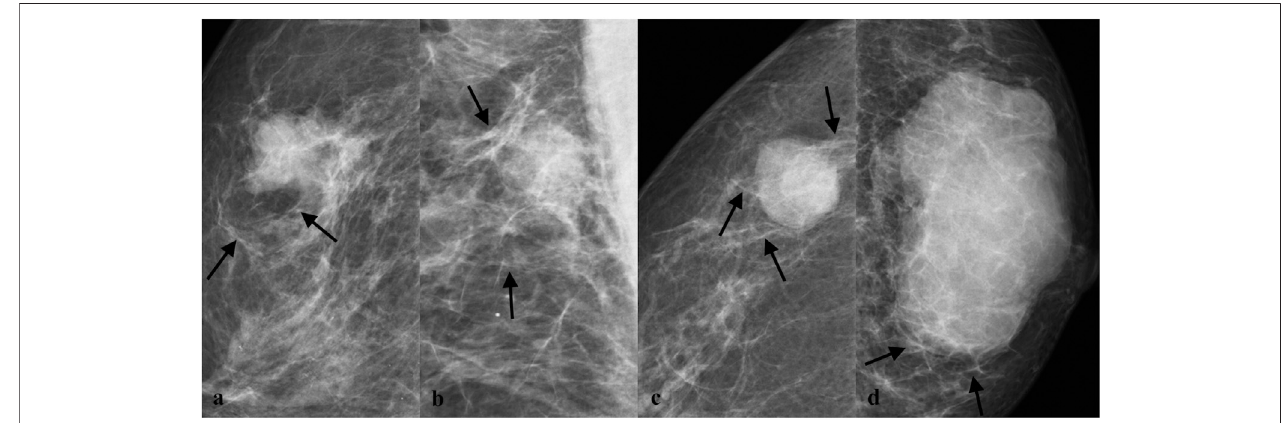
FIGURE 4 | Subclassi fi cation of trabecular abnormalities. (A) A mass with parallel trabecula sign in a 56-year-old woman proved to be invasive ductal carcinoma grade Ⅲ pathologically. (B) A mass with parallel trabecula sign in a 55-year-old woman proved to be invasive ductal carcinoma grade Ⅲ pathologically. (C) A mass